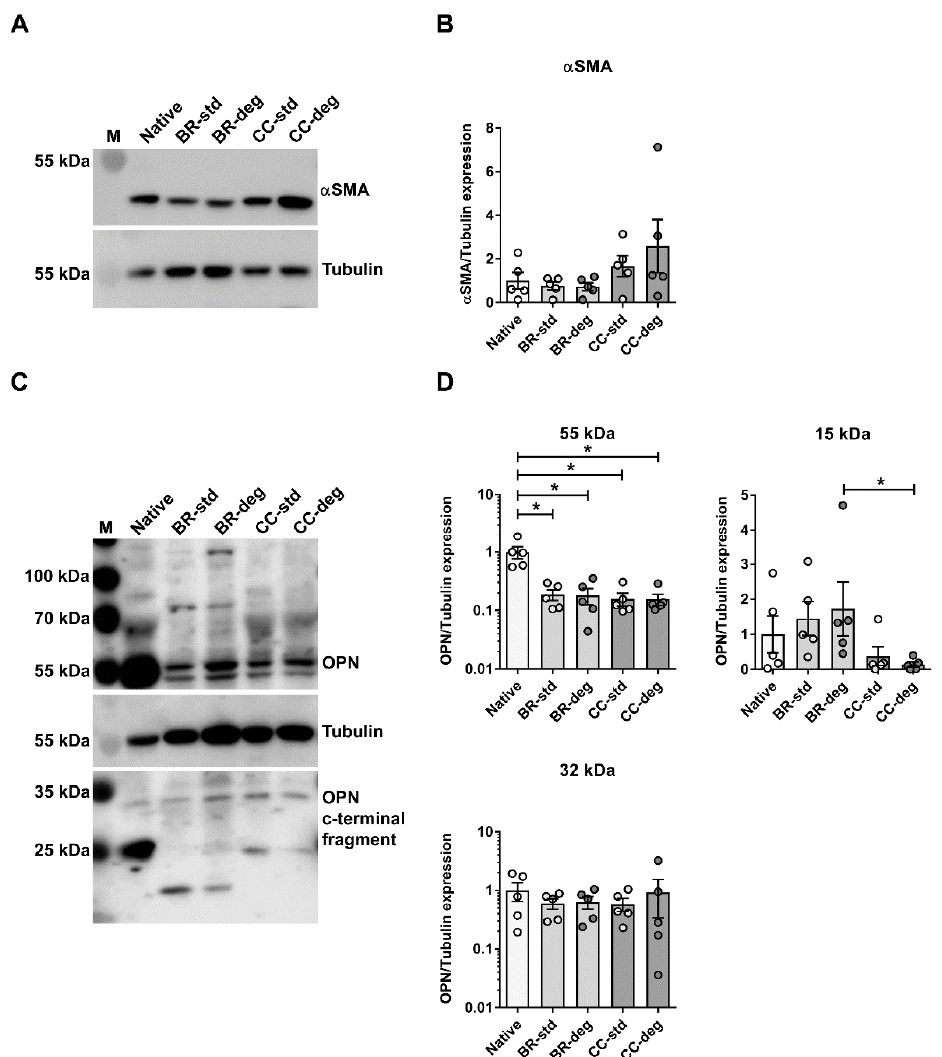
Figure 6. Bioreactor cultivation led to altered OPN protein levels. Lysates were analyzed by Western blot with specific antibodies for ( A , B ) α SMA, ( C , D ) osteopontin (OPN), and Tubulin as loading control. Positions of molecular weight markers are indicated on the left . ( B , D ) Graphic representation of band intensities is displayed on the right, using means and standard error of means ( n = 5). For OPN protein bands at approximately 55 kDa and 32 kDa were subjected to intensity analysis. Kruskal–Wallis test was performed and significance of Dunn’s post-test is indicated with stars (* p < 0.05). Control: native leaflets, BR: bioreactor cultivation, CC: static cultivation in cell culture, std: using standard medium, deg: using pro-degenerative medium.